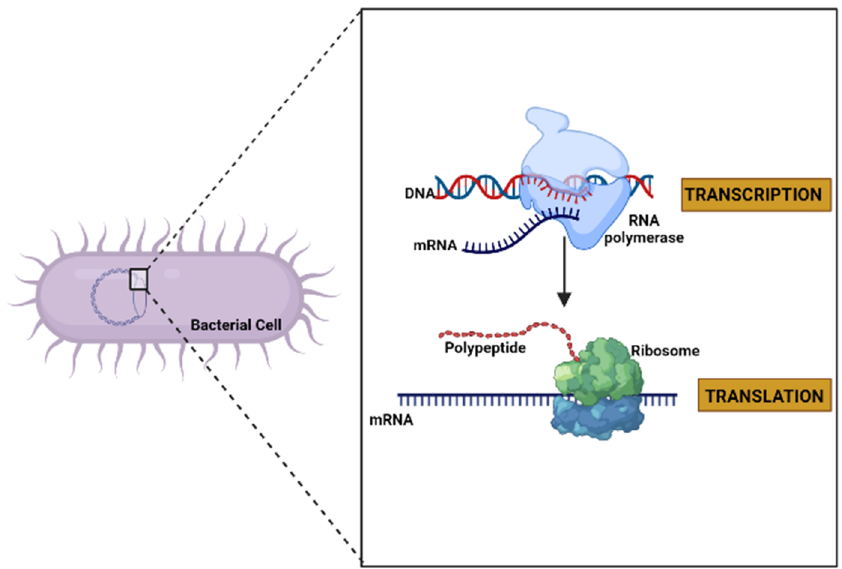
Figure 2. General diagram of the expression of a gene to protein through the processes of transcription and translation in a bacterial cell (created by Biorender.com) (accessed on 17 June 2022).